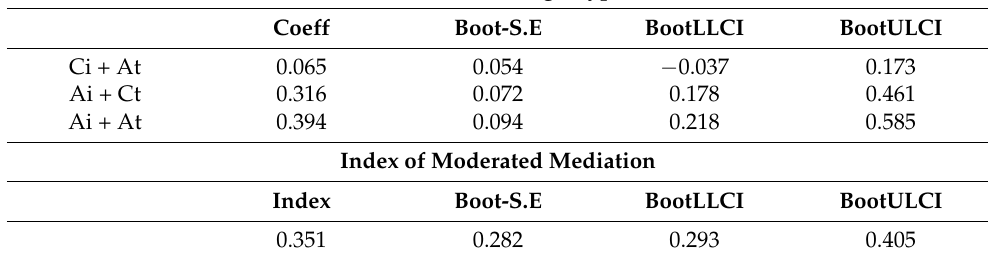
Table 6. The mediating effect of cognitive fluency in combination design style and construal level on match rate.